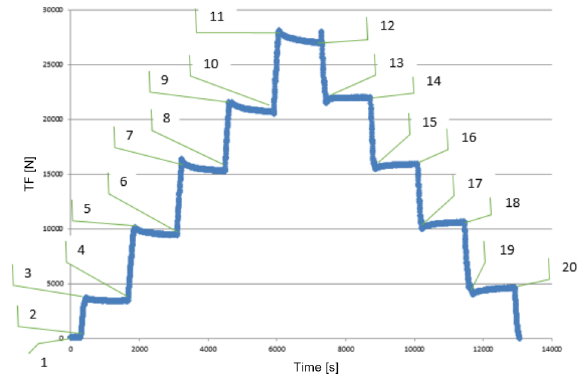
Figure 7: The time course of TF measurement at positions ID23, ID24